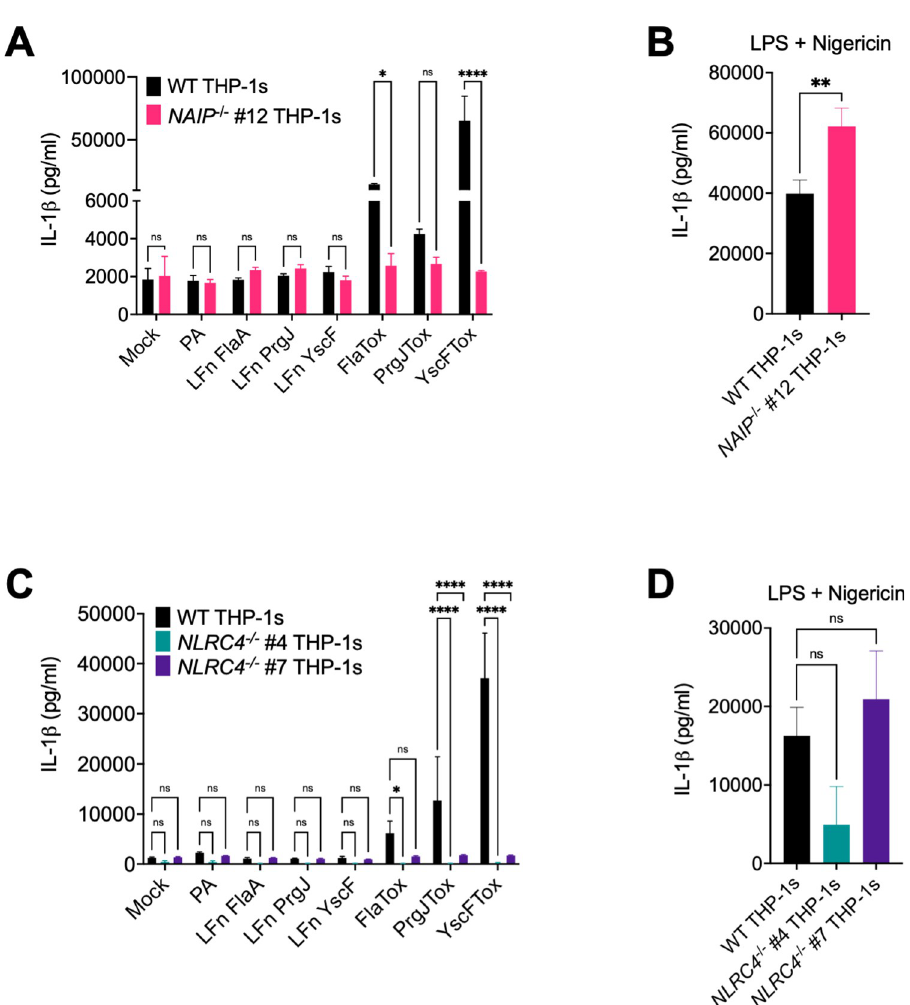
Fig 1. NAIP and NLRC4 are necessary for inflammasome responses to T3SS ligands in human macrophages. WT, NAIP -/- clone #12, and two independent clones of NLRC4 -/- THP-1 monocyte-derived macrophages were primed with 100 ng/mL Pam3CSK4 for 16 hours. Cells were then treated with PBS (Mock), PA alone, LFnFlaA 310–475 alone (LFnFlaA), LFnPrgJ alone, LFnYscF alone, PA+LFnFlaA 310–475 (FlaTox), PA+LFnPrgJ (PrgJTox), or PA+LFnYscF (YscFTox) for 6 hours (A, C). As a control, cells were primed with 500 ng/mL LPS for 4 hours and treated with 10 μ M nigericin for 6 hours (B, D). Release of IL-1 β into the supernatant was measured by ELISA. ns–not significant, � p < 0.05, �� p < 0.01, ���� p < 0.0001 by Sˇı ´ da ´ k’s multiple comparisons test (A), or by unpaired t-test (B), or by Dunnett’s multiple comparisons test (C, D). Error bars represent the standard deviation of triplicate wells from one experiment. Data shown are representative of at least three independent experiments.